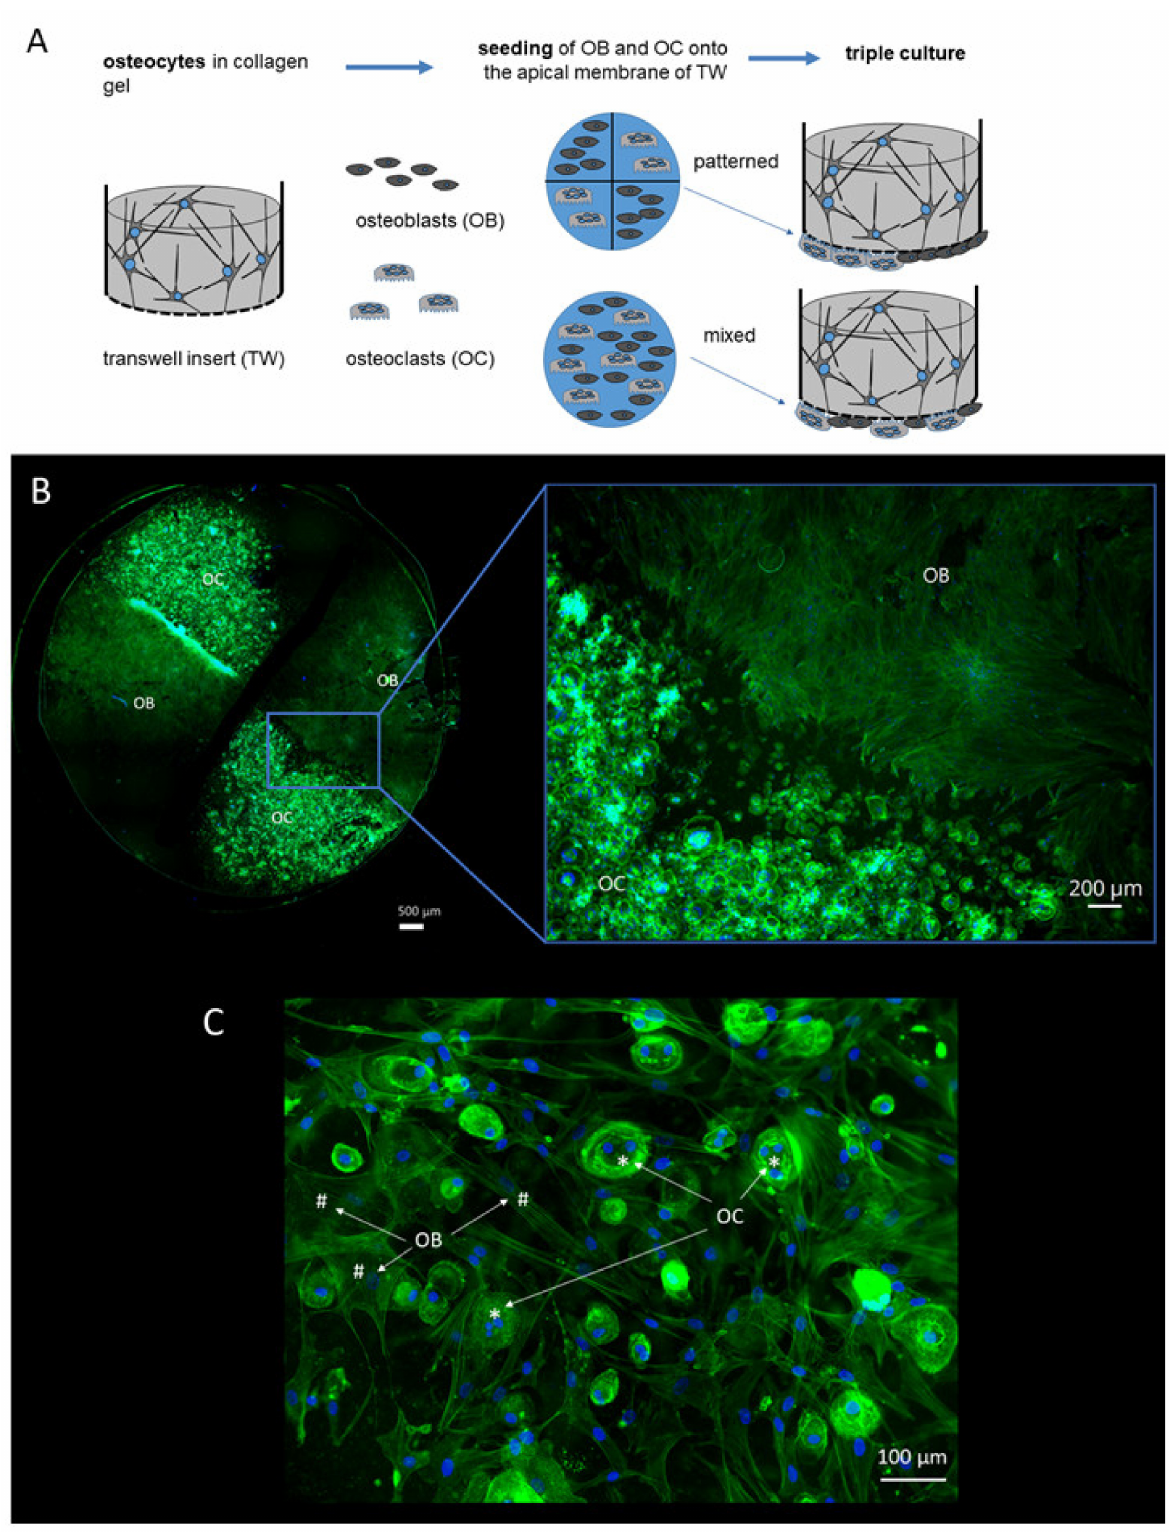
Figure 1. Triple culture setup for patterned and mixed seeding of OC and OB ( A ) OB and OC on the porous membrane after patterned seeding ( B ) as well as mixed seeding ( C ) and 7 days of triple culture. Fixed cells were stained with Alexa fluor 488 phalloidin and DAPI to stain cytoskeleton (green) and nuclei